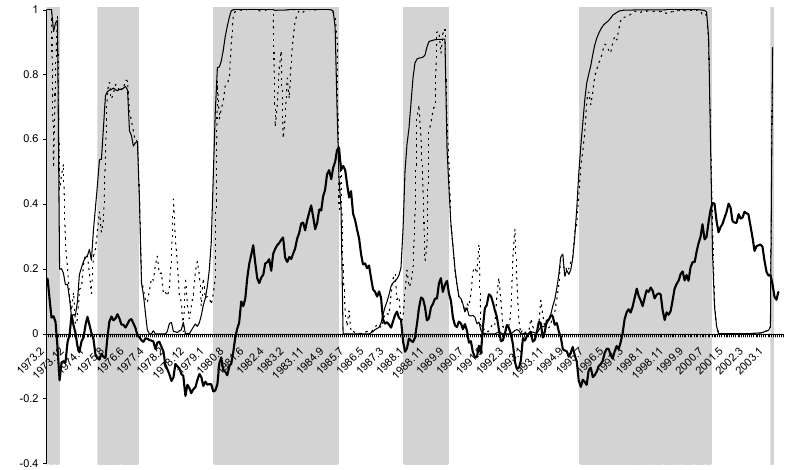
Figure 3. Real exchange rate and smoothed probability of being in the bubble regime (extended model). Note: The bold line is the real exchange rate from Equation (1). The thin black line is the smoothed probability of being in the bubble regime from Equation (8), and the dotted line is the series of filter probabilities from Equation (7). The shadowed rectangles represent the periods when the real exchange rate is identified as being in the bubble regime when P(s t = 1 | Ω T ) > 0.5.